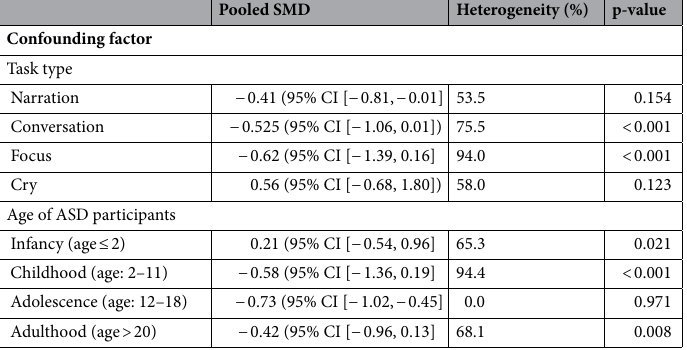
Table 5. Subgroup analyses for the difference of pitch variability between ASD and TD groups. The voice elicitation tasks and the age of participants were confounding factors.